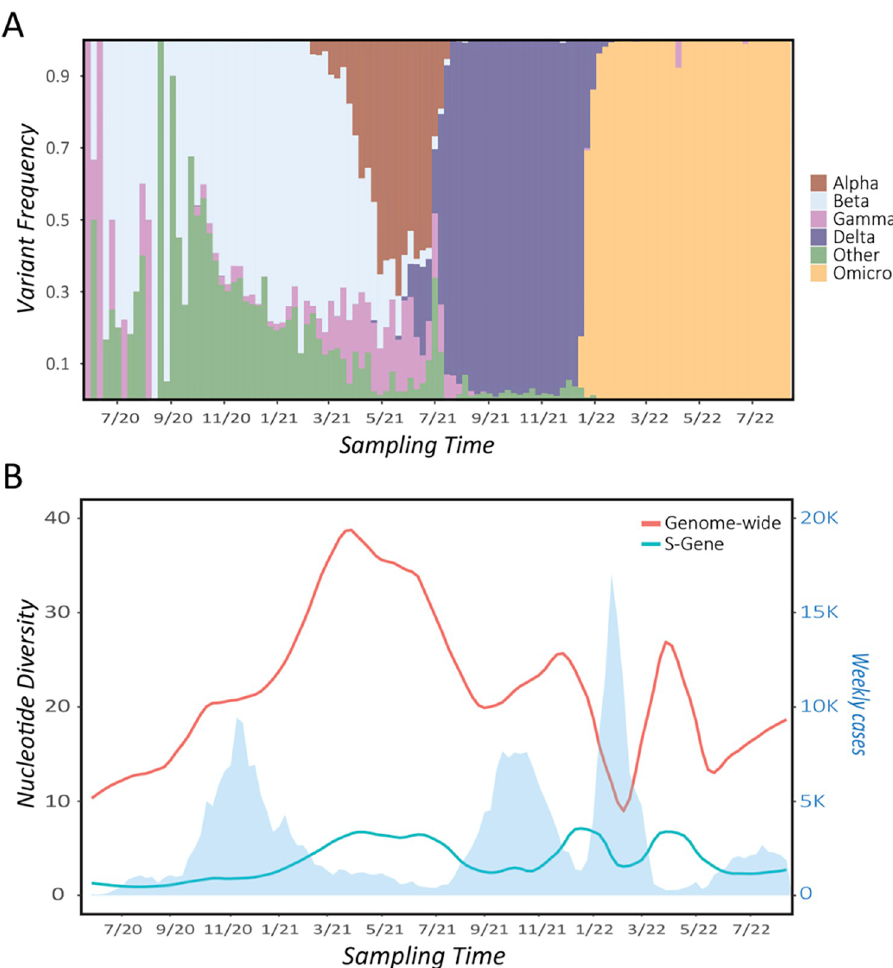
Fig 1. SARS-CoV-2 variant frequencies and genetic diversity through time, given for the state of Montana as illustration. (A) Frequency of major WHO-defined variants of concern (VOCs), binned by week of sampling as derived from GISAID metadata. (B) Average pairwise nucleotide differences between consensus sequence genomes isolated from patient samples genome-wide (orange line) and within the S-gene encoding the spike protein (blue line). As shown, local spread of major VOCs induced corresponding drops in overall genetic diversity across consensus sequences and within the S-gene. Note that while Beta dominated early in Montana, multiple variants cocirculated at appreciable frequency in 2020 to 2021, and the dominant observed strain differed by location. Consensus sequences were downloaded from GISAID ( n = 21,799), binned by week, and aligned to the SARS-CoV-2 reference sequence using Nextalign. Diversity was calculated in R, using the package PopGenome. Local polynomial regression fitting (method loess) was used in the R package ggplot2 to model diversity through time with the formula y ~ x. Case data (given by the light blue shading) were downloaded from the